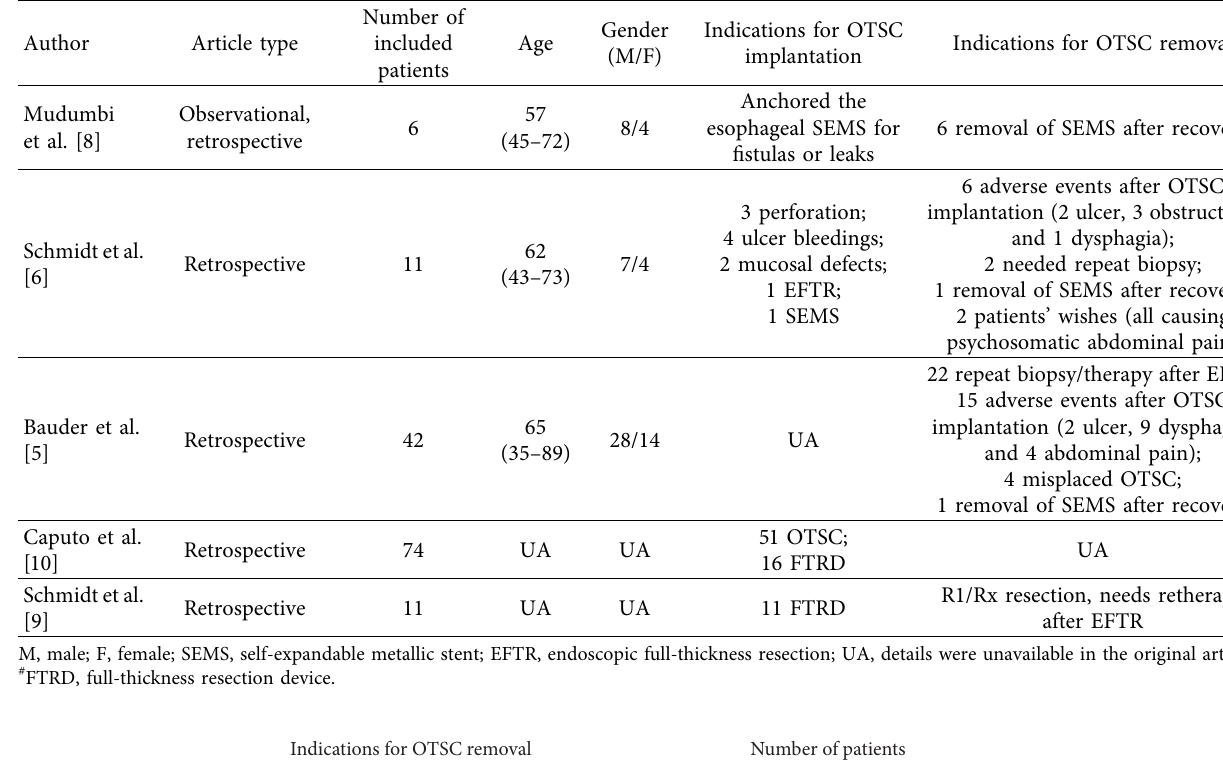
Table 3: Characteristics of the included clinical trials.